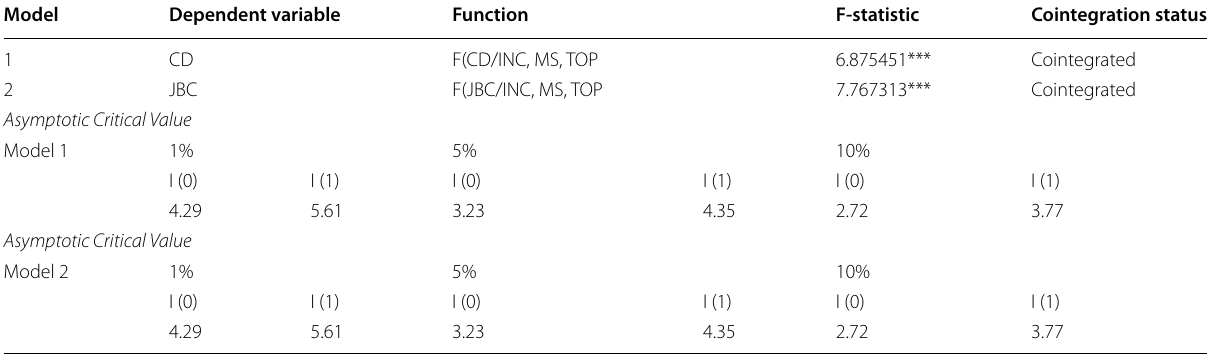
Source Estimated using Microfit 5.1 package *, **, and *** shows 10, 5 and 1% levels of significance respectively